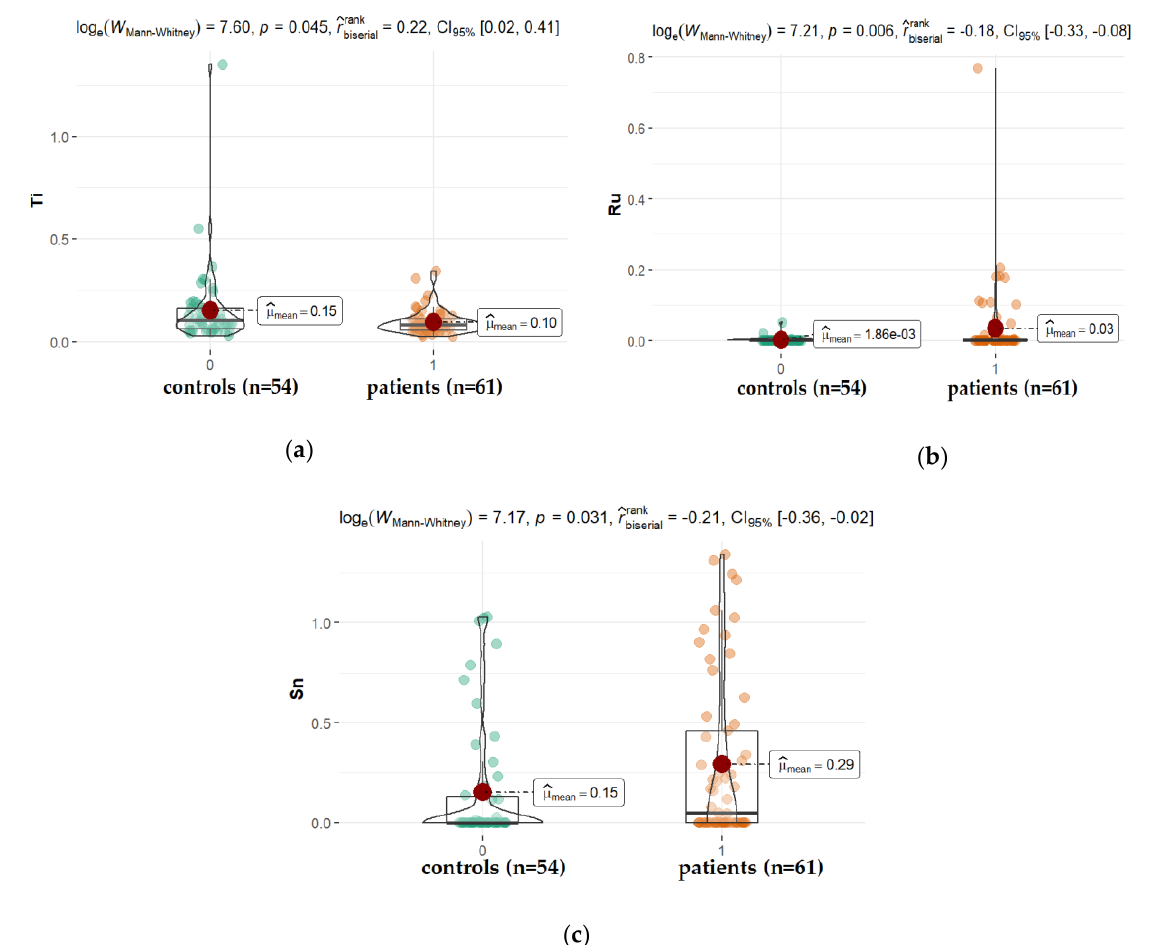
Figure 6. Statistical significance of differences in Tl ( a ), Ru ( b ), and Sn ( c ), content in AH of patients with hypertension compared to controls.